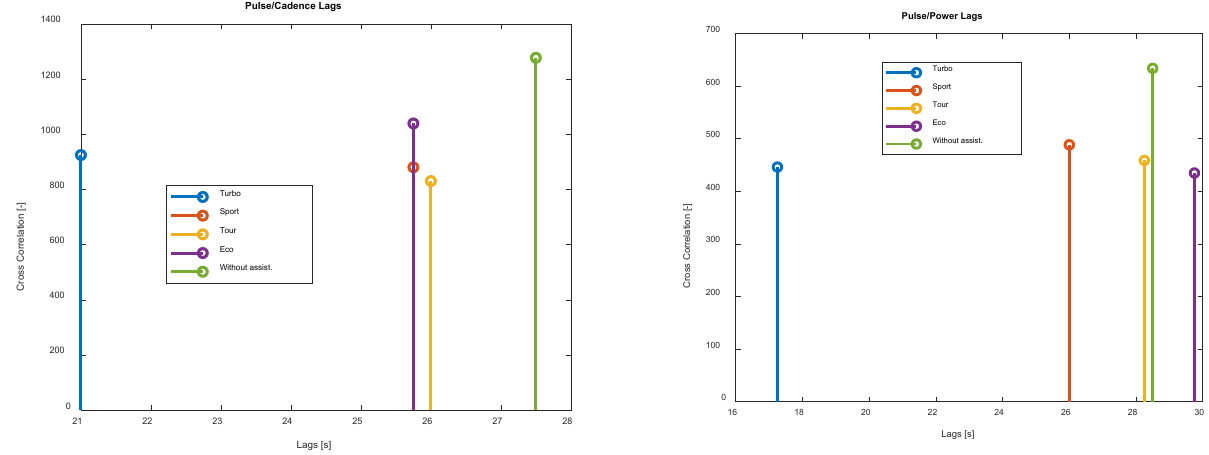
Figure 19. Delays in HR signals to cadence ( left ) and to power ( right ).